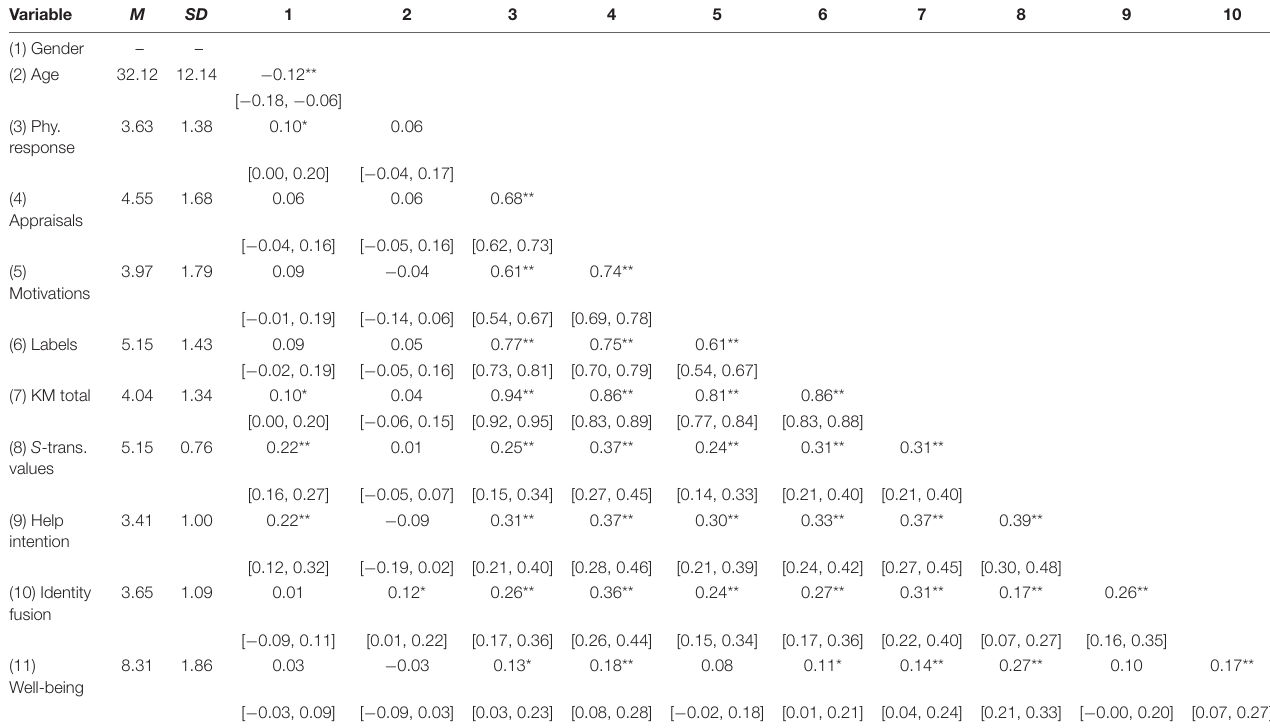
TABLE 5 | Descriptive and correlation analyses of interest variables after answering the Kama Muta prototypical video. Variable